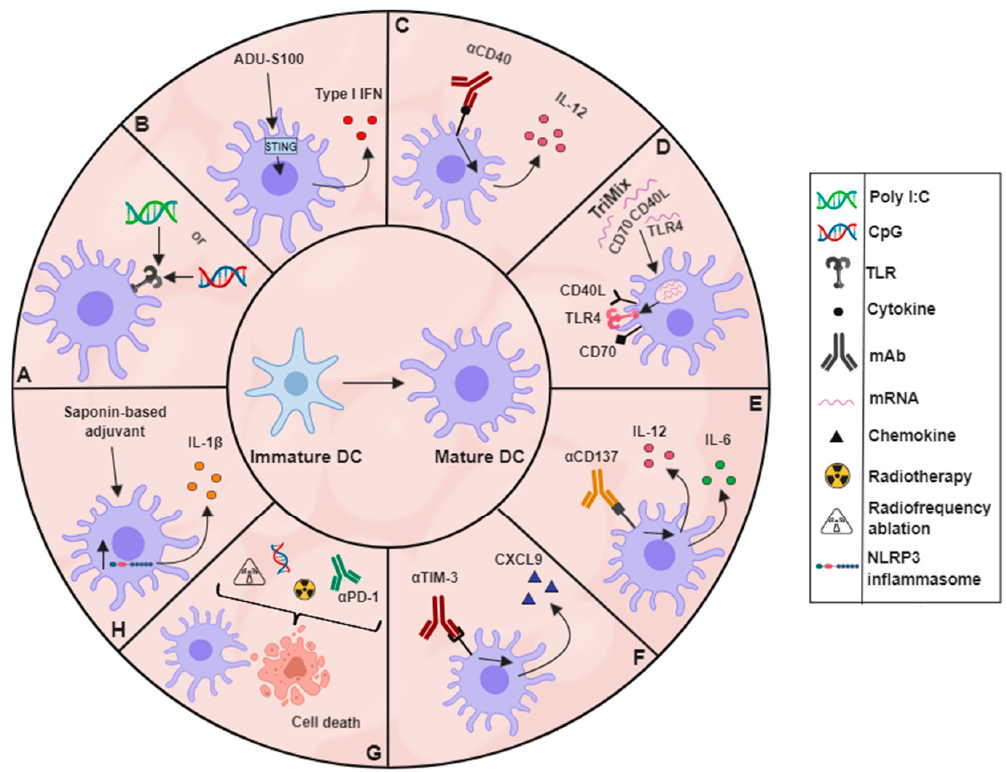
Figure 1. Different strategies with the potential to activate DCs within the TME. ( A ) TLR agonist- mediated DC stimulation via CpG or Poly I:C. ( B ) Activation of STING via STING agonists. ( C ) Direct DC maturation via CD40 agonism. ( D ) TriMix mRNA administration. ( E ) Altering the DC phenotype by using an agonistic mAb to CD137 ( E ) or an antagonistic antibody to TIM-3 ( F ). ( G ) Different combination therapies causing immunogenic cell death while subsequently activating DCs. ( H ) Use of saponin-based adjuvants to activate DCs.